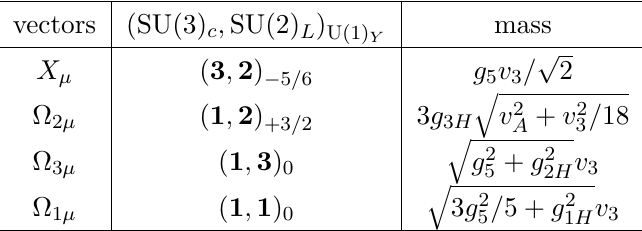
Table 5. The mass spectrum of the gauge bosons. The X µ is the SU(5) gauge fields. Ω 2 µ , Ω 3 µ and Ω 1 µ are the SU(3) H gauge